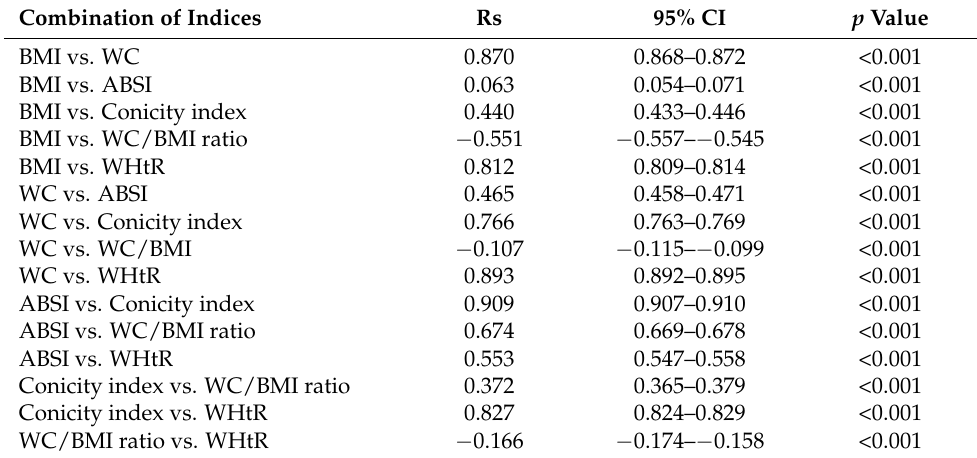
Table 4. Correlation between body adiposity